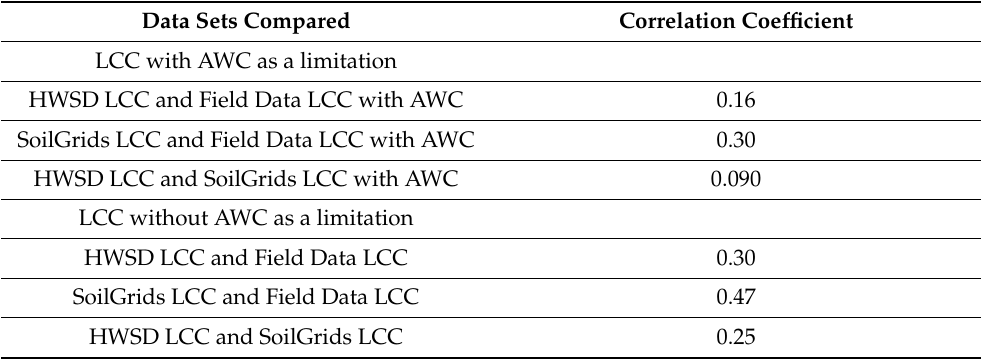
Table 10. Correlation coefficient between data sets on a pixel-by-pixel basis.